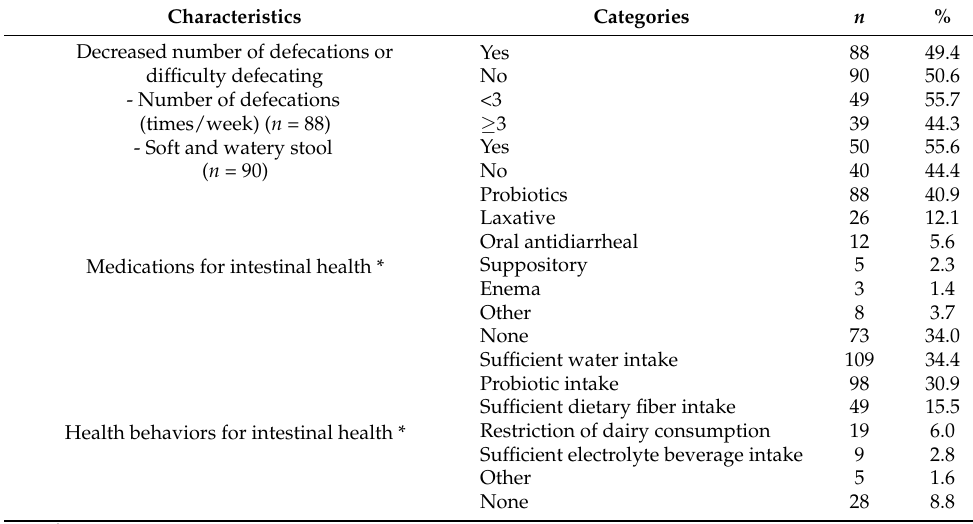
Table 1. Characteristics related to irritable bowel syndrome (N =